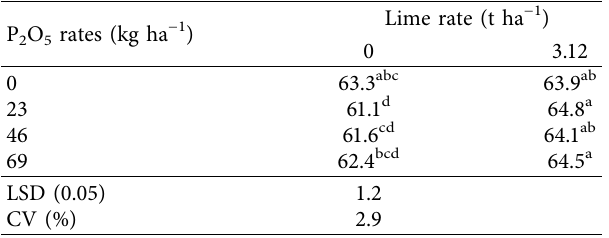
Table 2: Interaction effect of phosphorus with lime rates on days to 50% flowering.